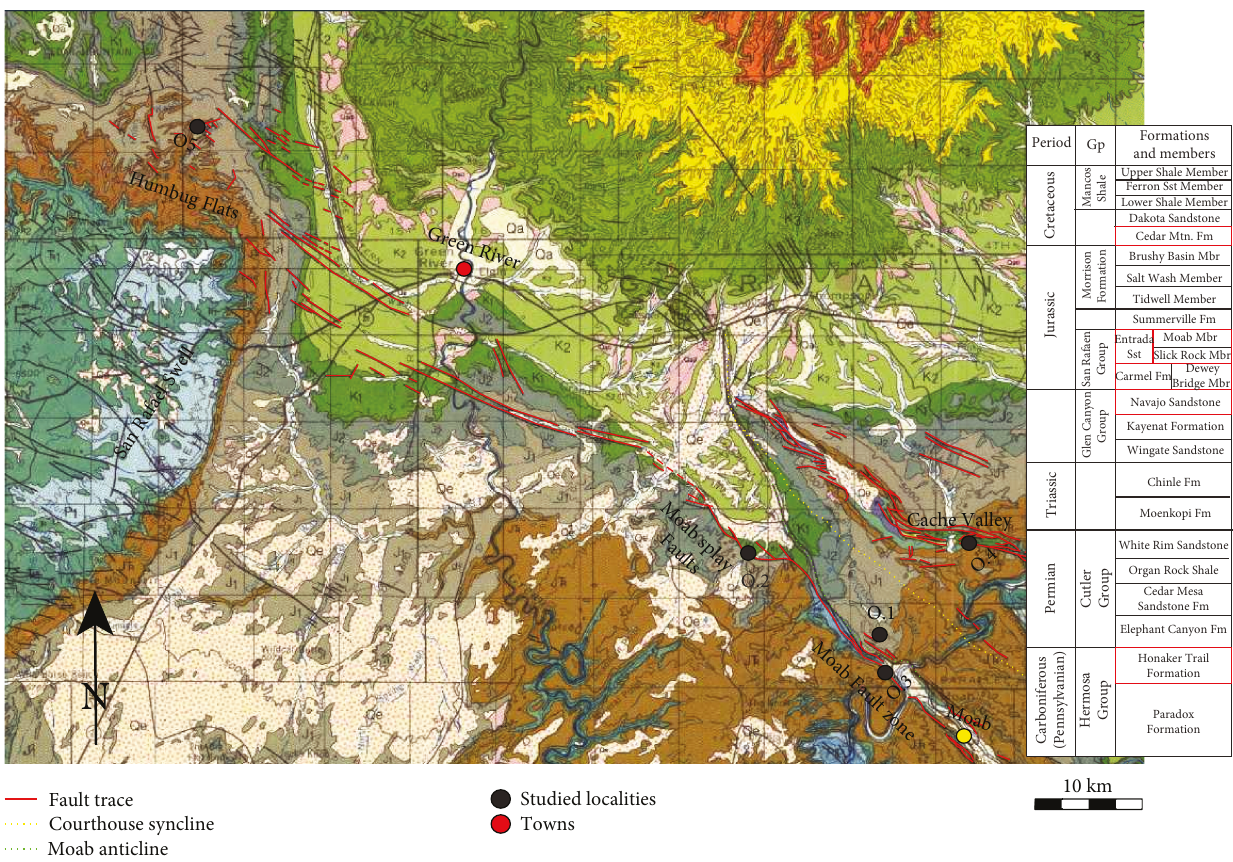
Figure 15: Geological map of Utah together with the stratigraphic column highlighting the studied formations. Note that the studied outcrops (O#) have been identi fi ed on the map. Modi fi ed after the geological map by Doelling